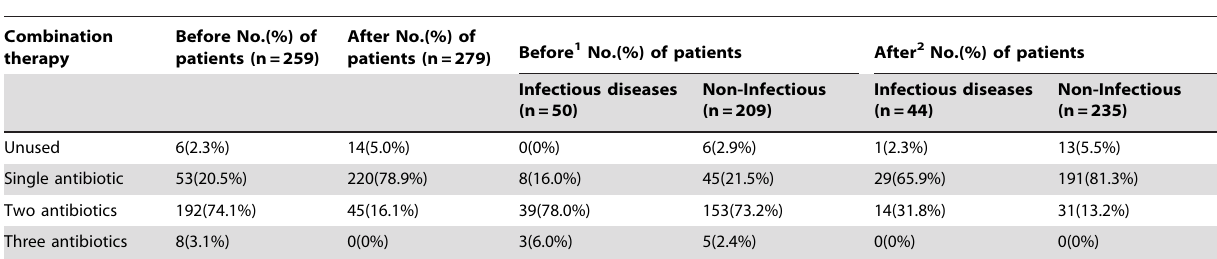
Table 4. Comparison of the ICU physicians’ initial antibiotic selection before and after antimicrobial stewardship.